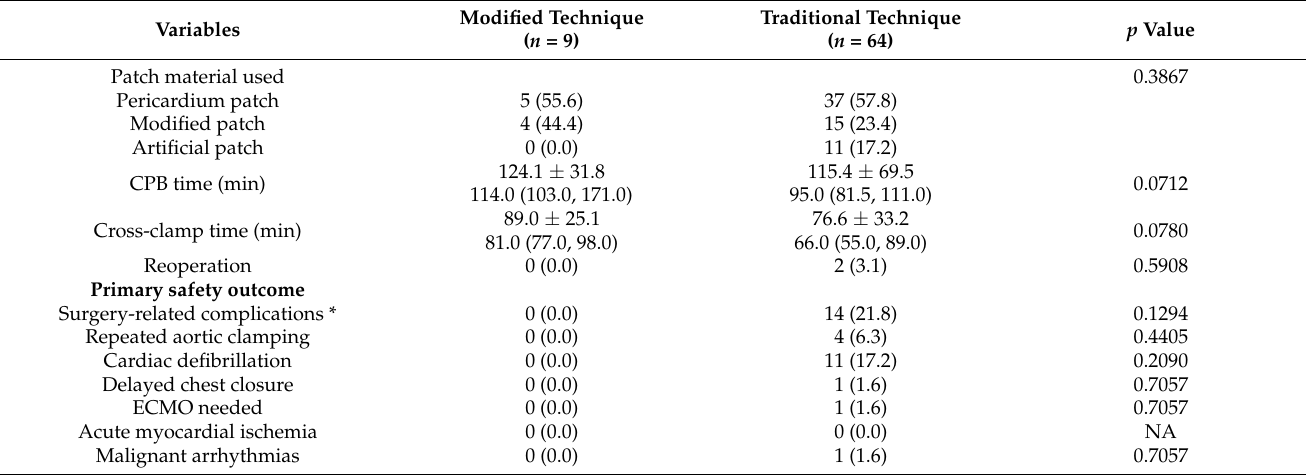
Table 2. Intra- or post-operative information of the patients with modified and traditional